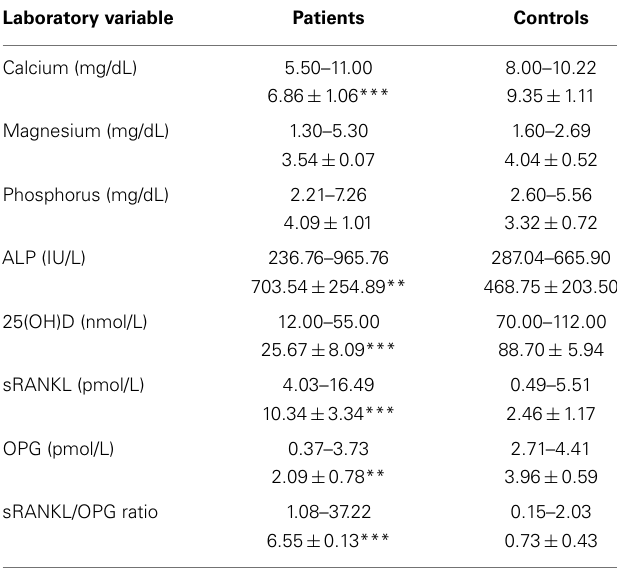
Table 3 |The frequency of patients with Dual-energy X-ray absorption (DEXA) abnormalities .